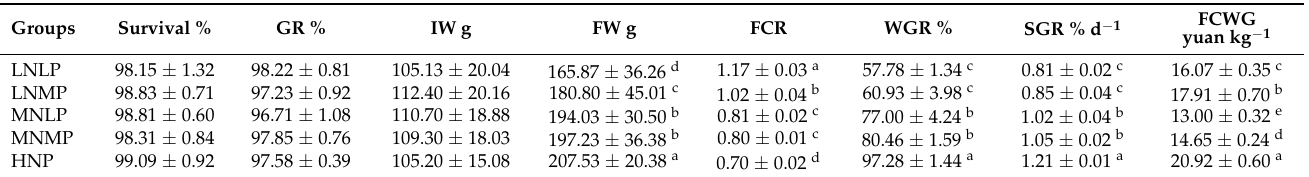
Table 2. Growth performance and feed utilization efficiency of hybrid grouper ( E. fuscoguttatus lanceolatus ) fed experimental diets for 8 ♂